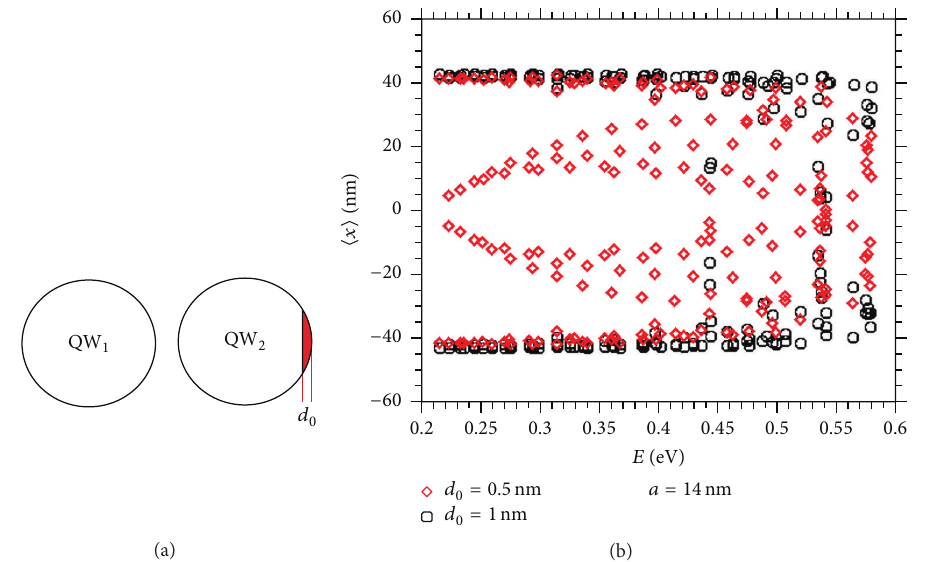
Figure 9: (a) Circle shaped DQW exhibiting an asymmetry generated by truncating the right quantum well (QW 2 ). (b) Electron average position ⟨𝑥⟩ plotted along electron spectrum of the asymmetric DQWs ( 𝑅 1 = 𝑅 2 = 40 nm and 𝑎 = 14 nm) for two different cut depths 𝑑 0 , inducing well contrasted symmetry violation within the DQW.